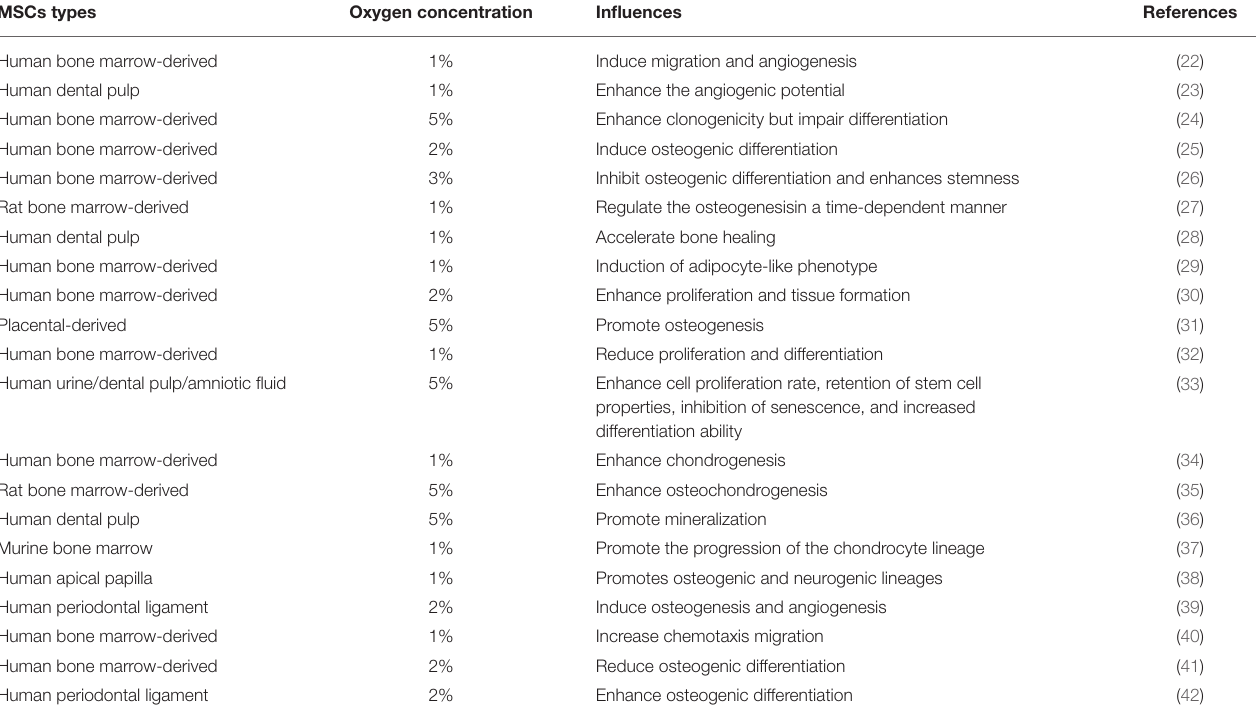
TABLE 1 | Effects of Hypoxia on the influences of